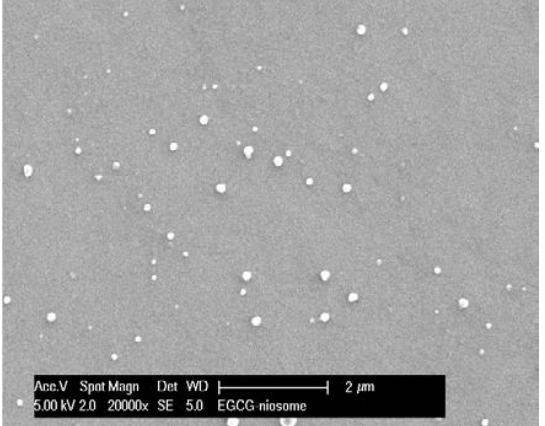
Figure 2. Scanning Electron Microscopy (SEM) image of the optimised EGCG niosomes.